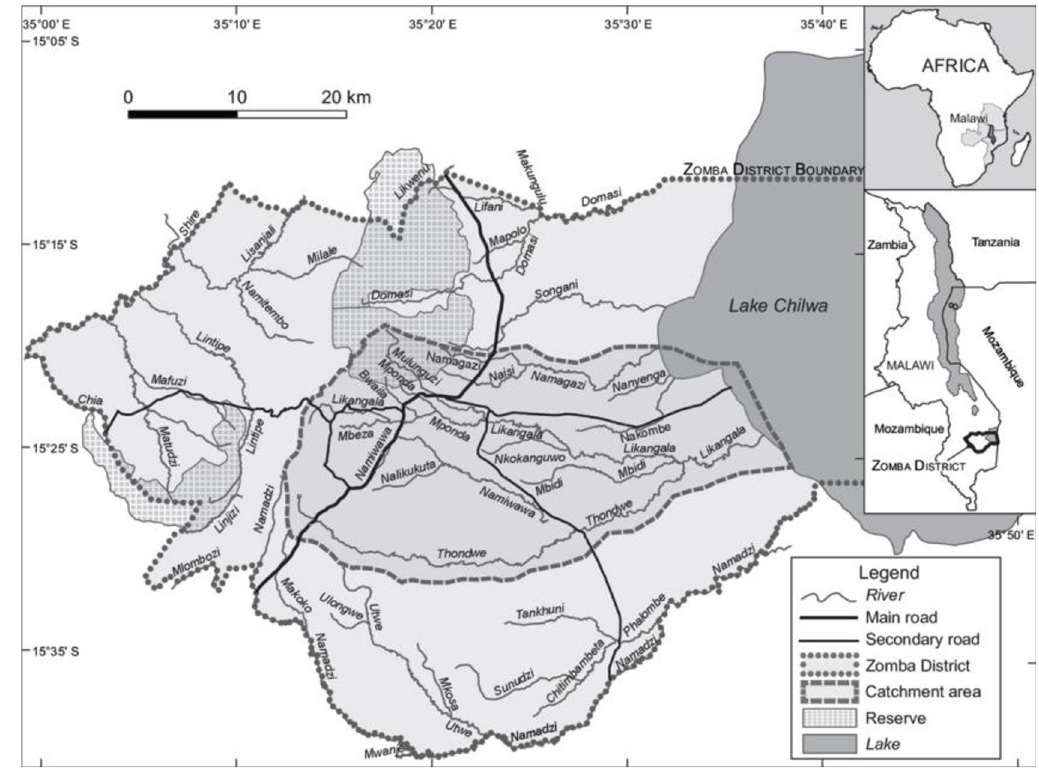
Fig 1. A map of Zomba depicting the study site catchment